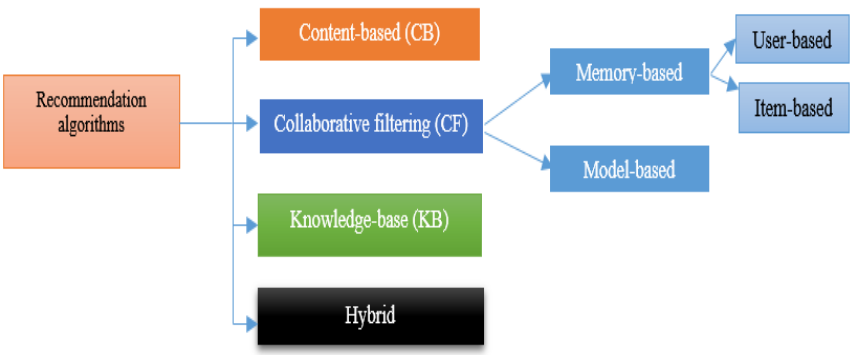
Figure 2. Current recommendation algorithms and categories.